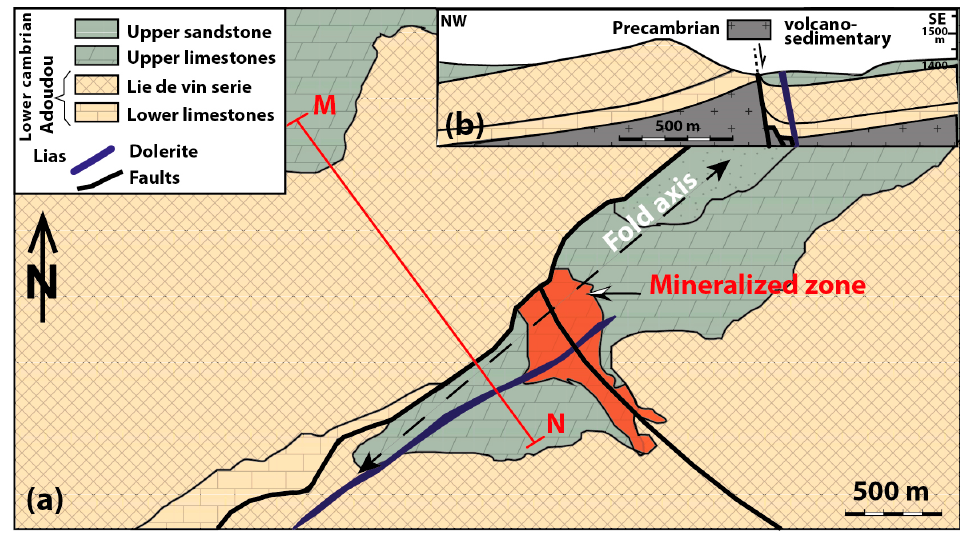
Figure 7. ( a ) Geological map of the Jbel Laassel mining district. ( b ) Geological cross-section M-N modified from Bourque et al. [21].